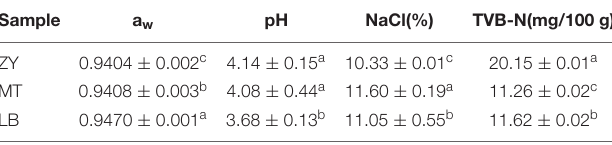
TABLE 1 | Physicochemical properties of SZR from different